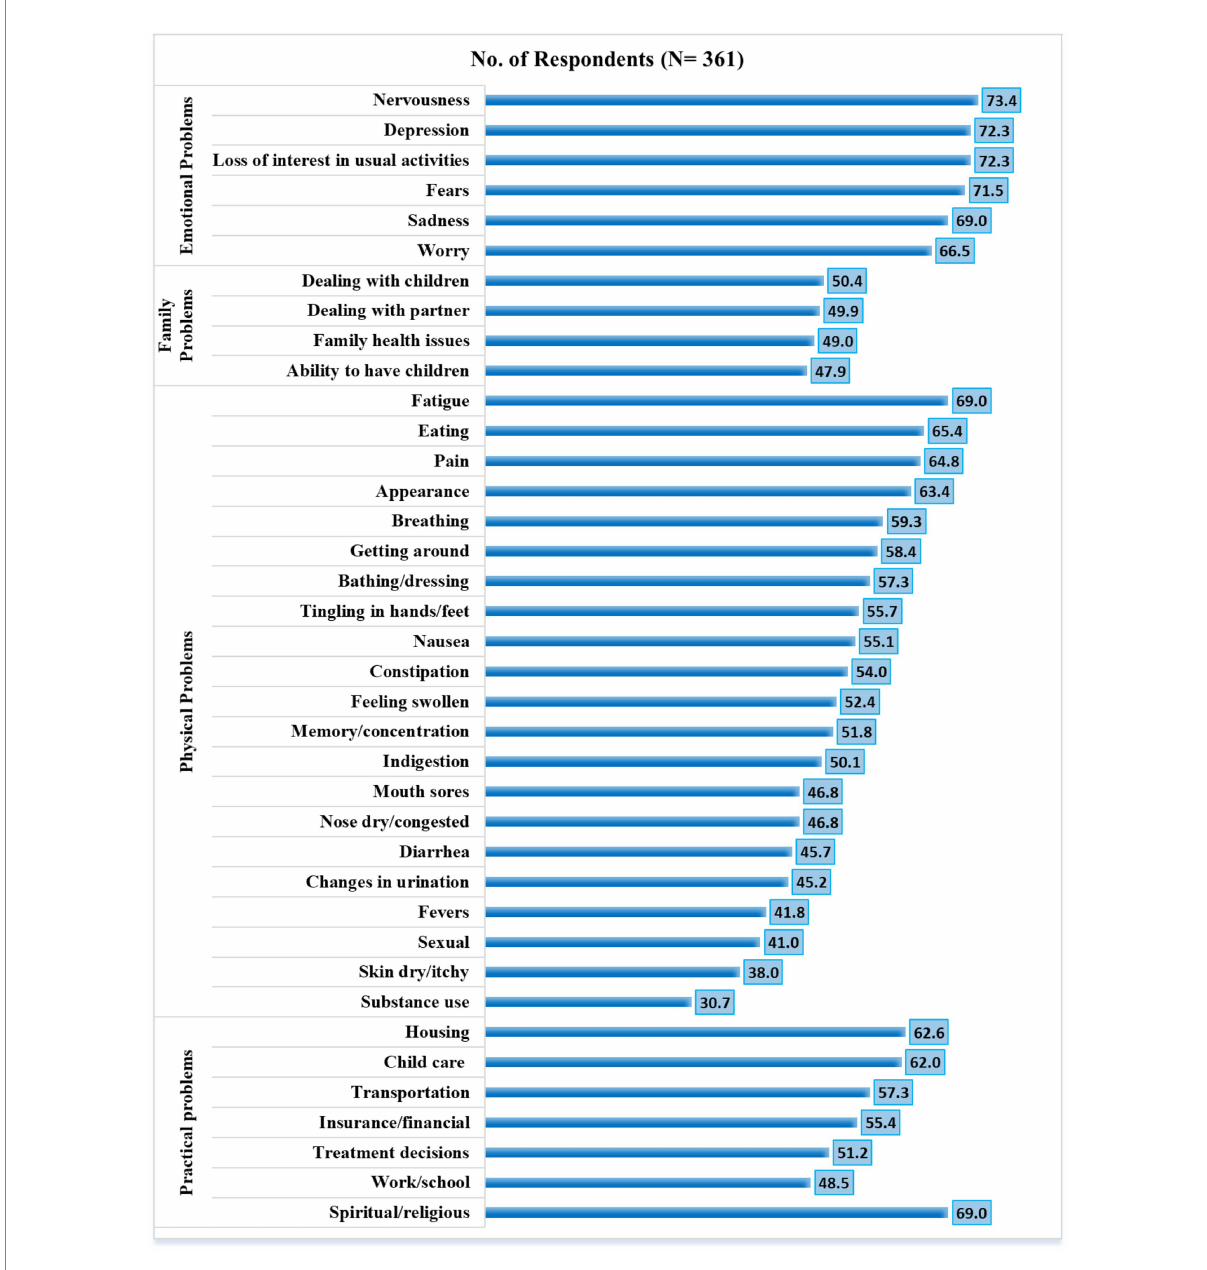
FIGURE 2 Percentage distribution of participants with respect to distress thermometer scale